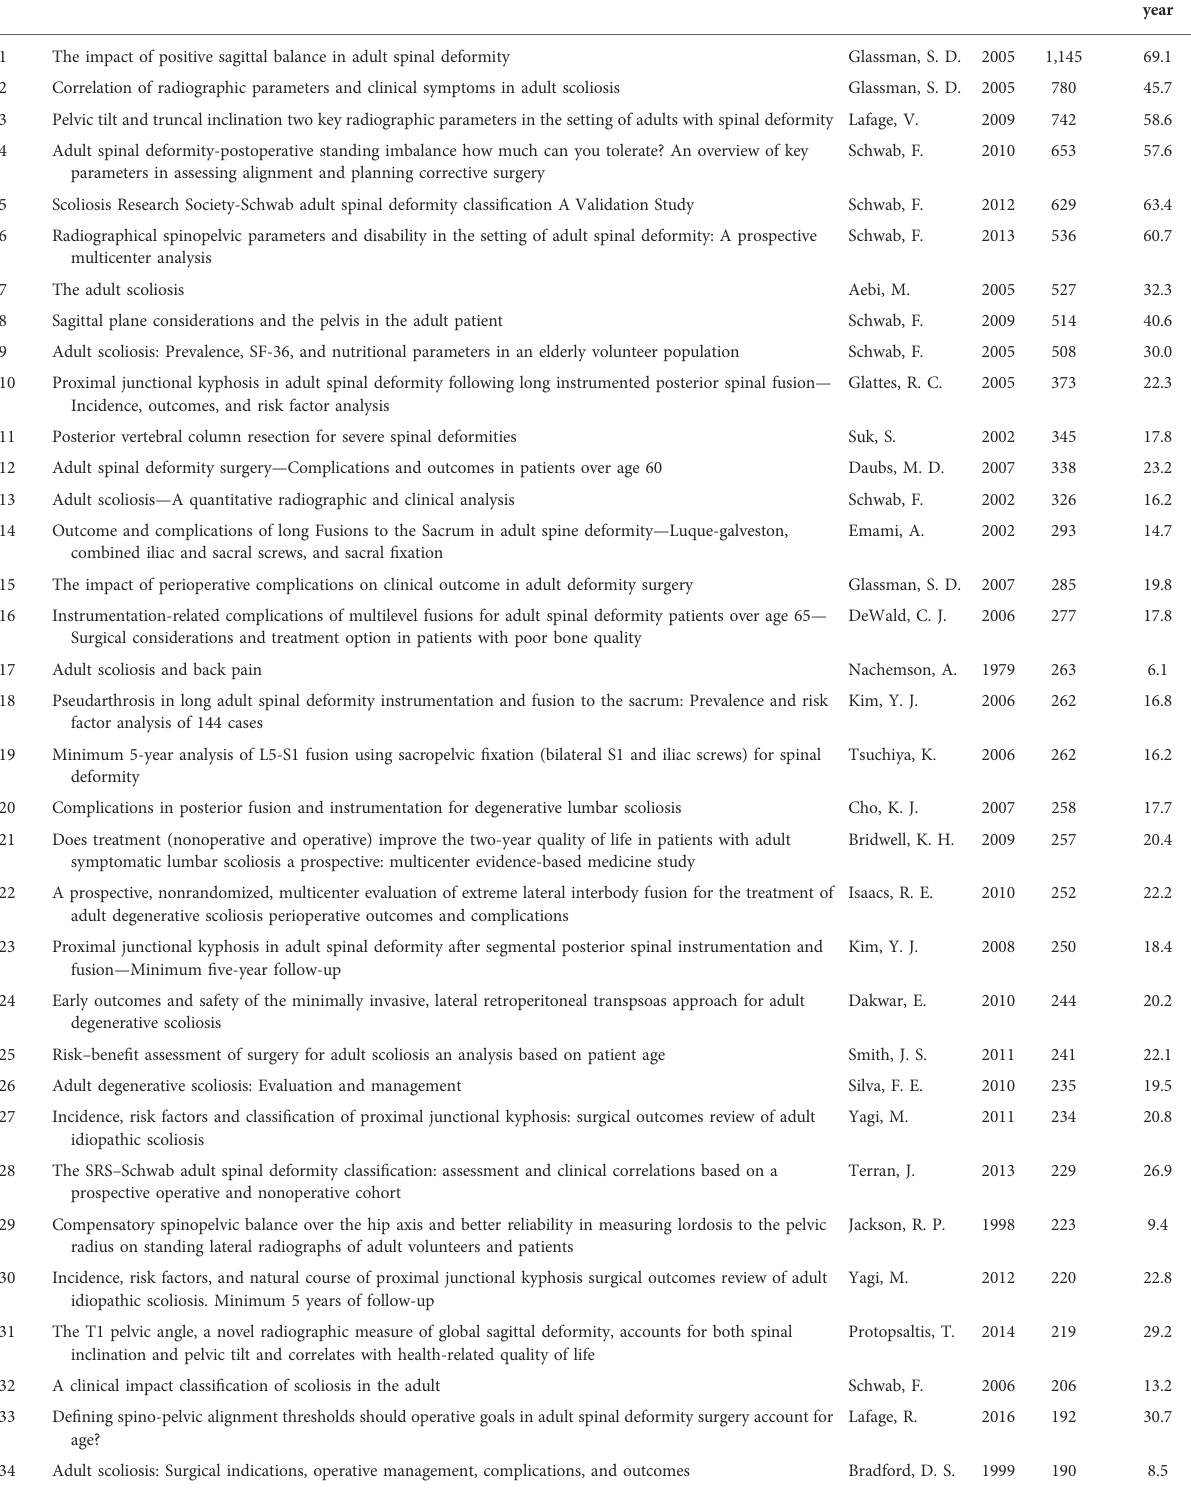
TABLE 1 The 100 most-cited articles on adult spinal deformity.